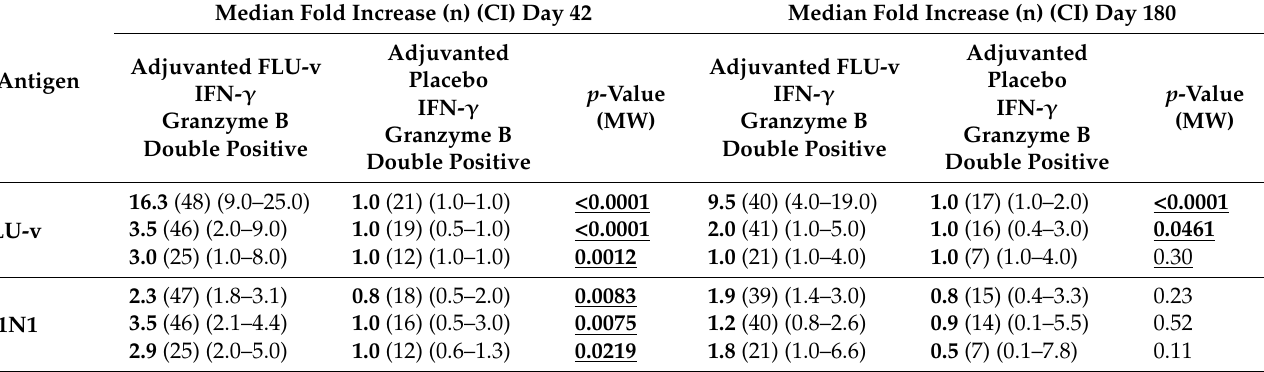
Table 3. Median fold increase in number of IFN- γ -producing, granzyme-producing, and dou- ble positive cells (SFU/million cells) in the adjuvanted vaccine and placebo group from day 0 to days 42 and 180. Cells were stimulated with a mix of four synthetic peptides that composed the FLU-v vaccine or with whole inactivated influenza strains (A/California/7/2009 (H1N1), A/Shanghai/24/1990 (H3N2), A/Vietnam/1194/2004 (NIBRG-14) (H5N1), A/Anhui/1/2013 (NIBRG-268) (H7N9), and B/Brisbane/9/2014 (Yamagata lineage)). Fold increase on days 42 and 180 was defined as the ratio between SFU counts on day 42 or 180, and SFU counts on day 0. n = number of samples to be included in the statistical analysis. CI = 95% confidence interval. The Mann–Whitney U test (MW) was used to compare fold increases between groups, and test the null hypothesis of equal distributions in the vaccine group and placebo group on day 42 and on day 180. Since we cannot reasonably assume that the distributions have the same shape, and only differ with respect to location, the Mann–Whitney U test cannot be interpreted as a comparison of medians. Significant differences are indicated with p -values in